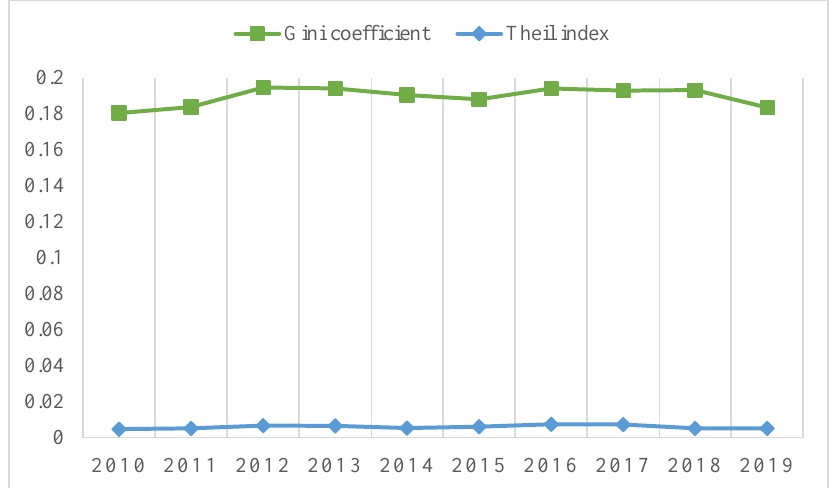
Figure 6. The evolution of the city–industry integration gap between economic zones. Table 7. Theil index and structural decomposition of development of city–industry integration in each region.